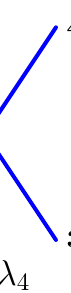
Figure 12. Diagrammatic representation of the Ten 1-Loop Integrals (cid:30) R (cid:30) R k 1 + k 2 ).